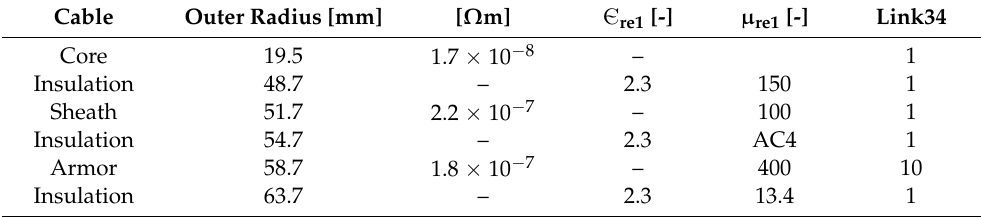
Table 4. Cable parameters.